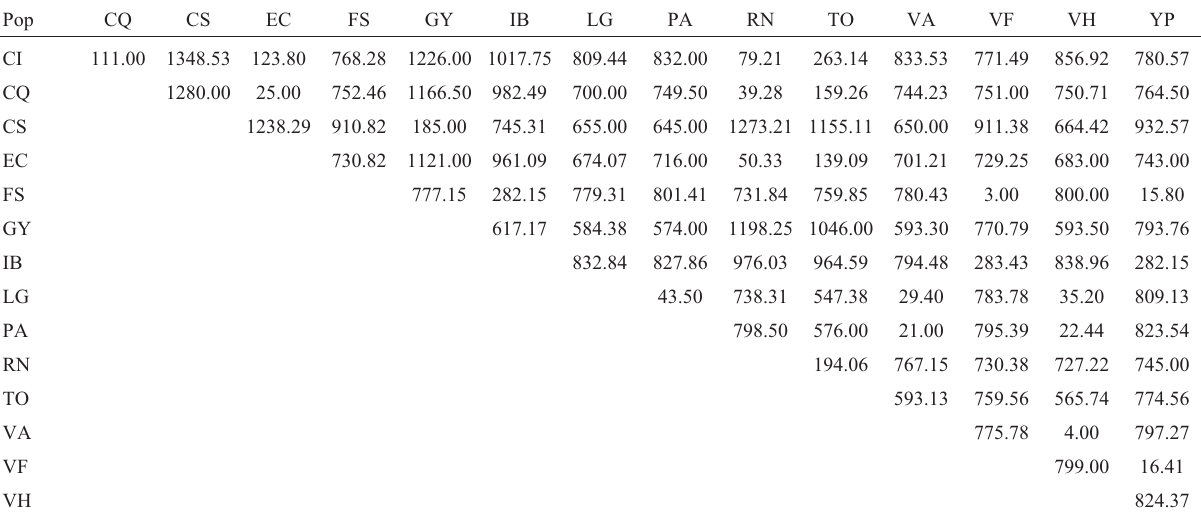
Table 2 - Pairwise geographic distances in kilometers between Acacia caven sampling